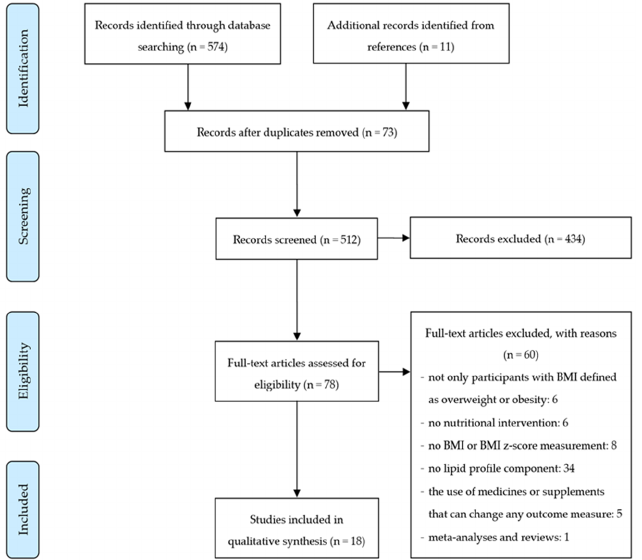
Figure 1. The flow diagram of the literature review